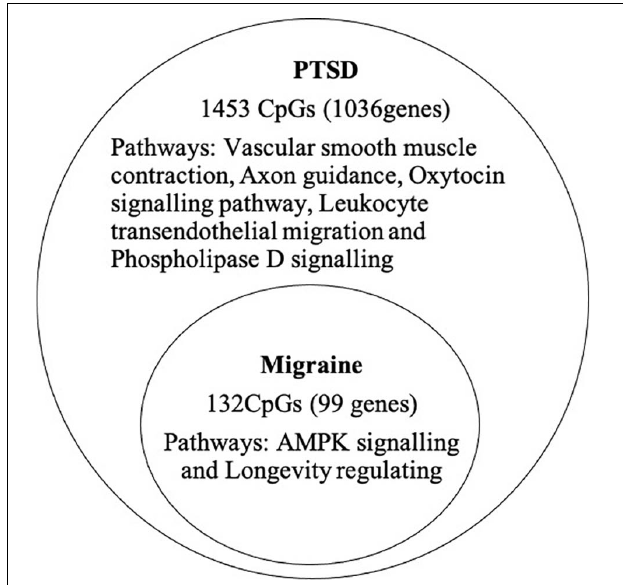
FIGURE 4 | Overlap of PTSD and migraine: Venn diagram of CpGs and genes significantly associated with PTSD (10% FDR) and also associated with migraine ( p <